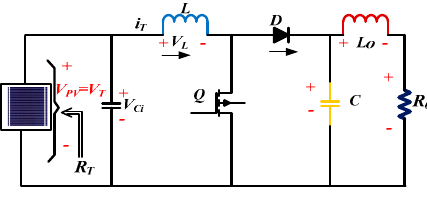
Figure 11. Conventional boost converter [19].